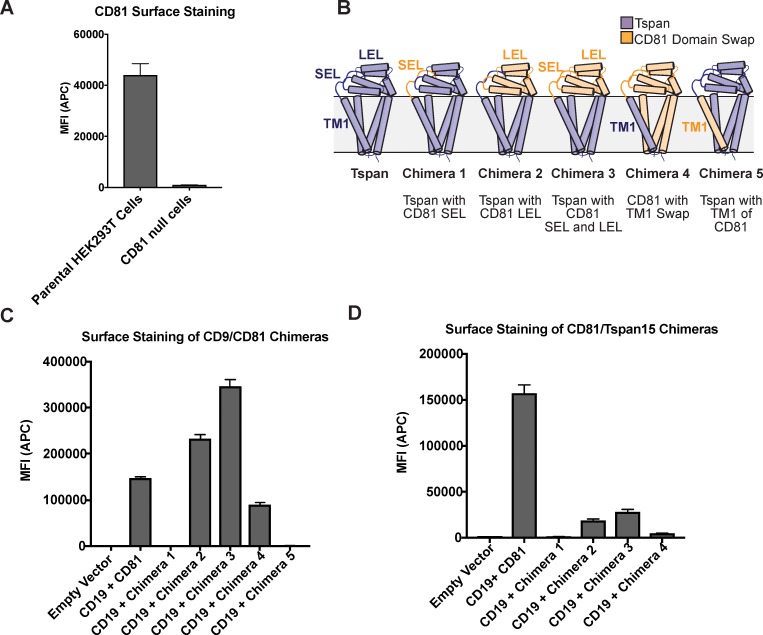
Surface staining of CD81 chimeras used in the CD19 Export Assay.Expression was analyzed using an anti-CD81 antibody, so only chimeras with the large extracellular loop of CD81 are detectable. (A) CD81 surface staining of parental HEK293T cells compared to CRISPR knockout cells. (B) Panel of CD81 chimeras used in export assay. (C) CD81 surface staining of CD9/CD81 chimeras detected with 5A6 antibody. (D) CD81 surface staining of CD81/Tspan15 C. elegans chimeras detected with 5A6 antibody. Error bars represent mean ± SEM of three independent experiments.